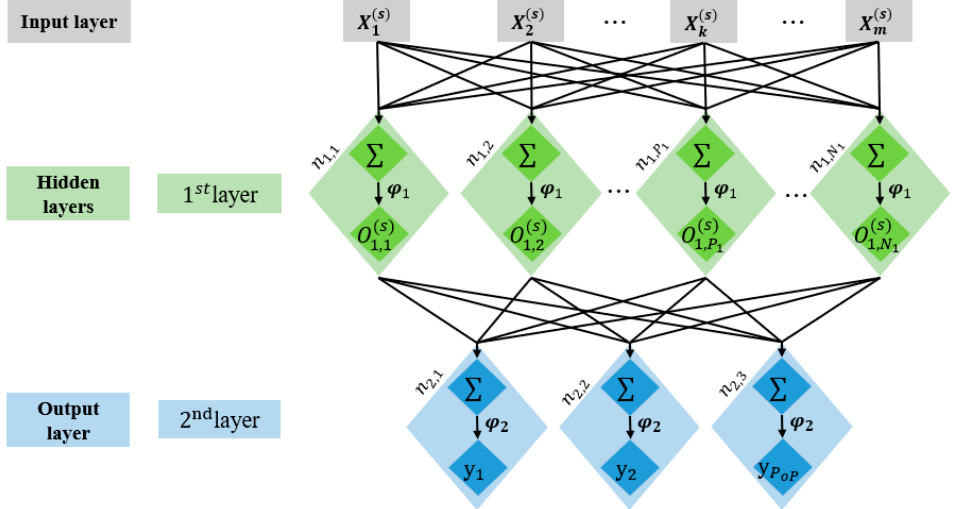
Figure 4. ANN framework used in this study.